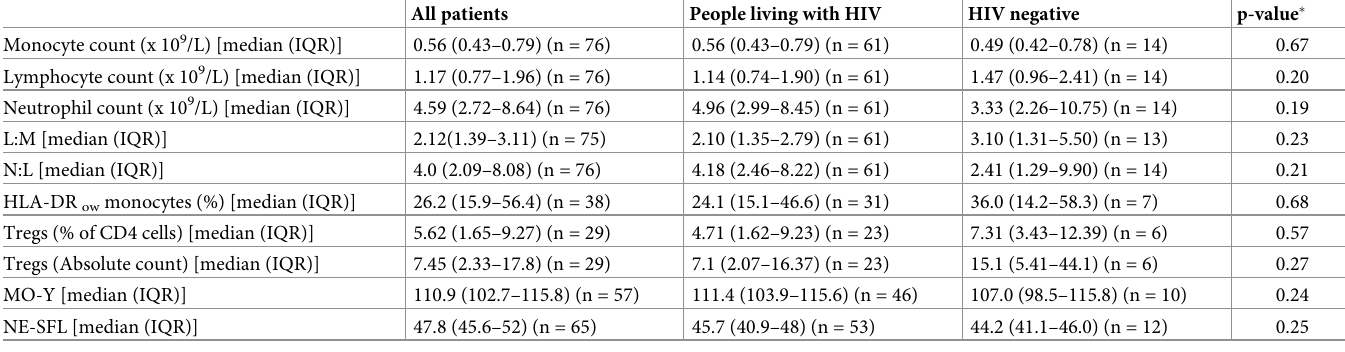
Table 3. Immune cell-related